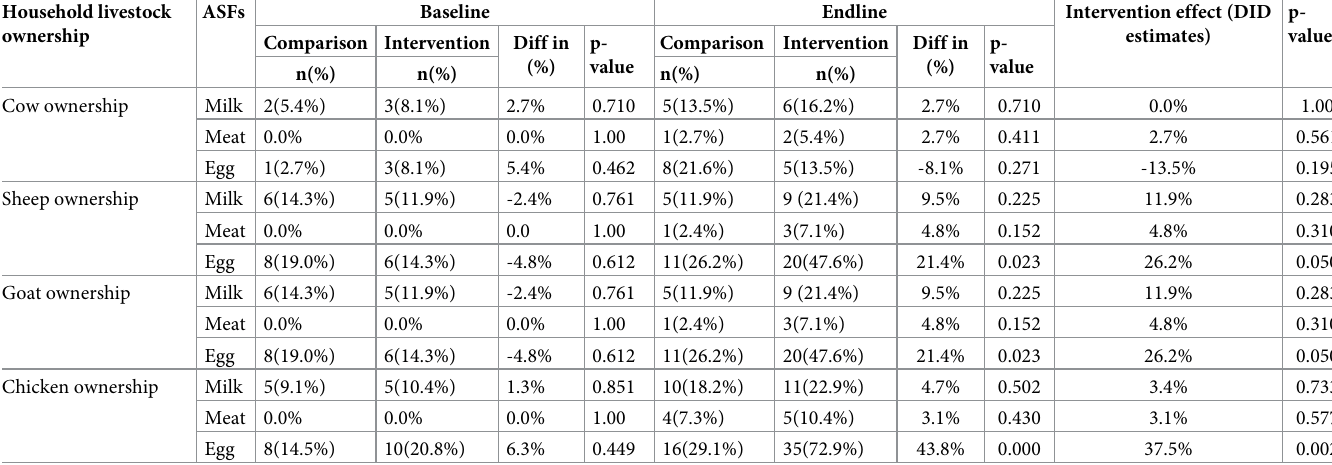
During the baseline, livestock ownership didn’t significantly influence the consumption of ASFs among children in both the intervention and comparison areas “Table 5”. Sheep and goats’ ownership was considerably higher among children in the intervention than Table 5. Associations between specific livestock ownership and animal source food consumption among children in rural districts of Tigray region, Ethiopia (dif- ference-in-difference analysis). Household livestock